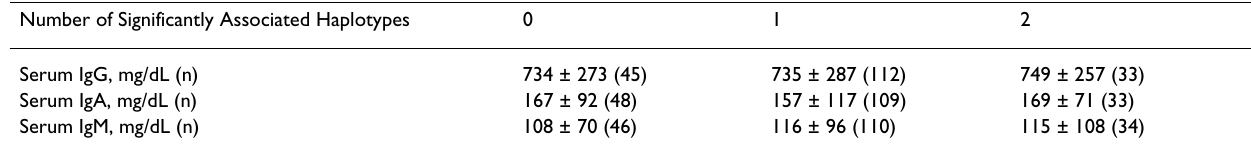
Table 6: Serum Immunoglobulin Concentrations in Index Patients with Significantly Associated HLA-A and -B Haplotypes. 1 Number of Significantly Associated Haplotypes